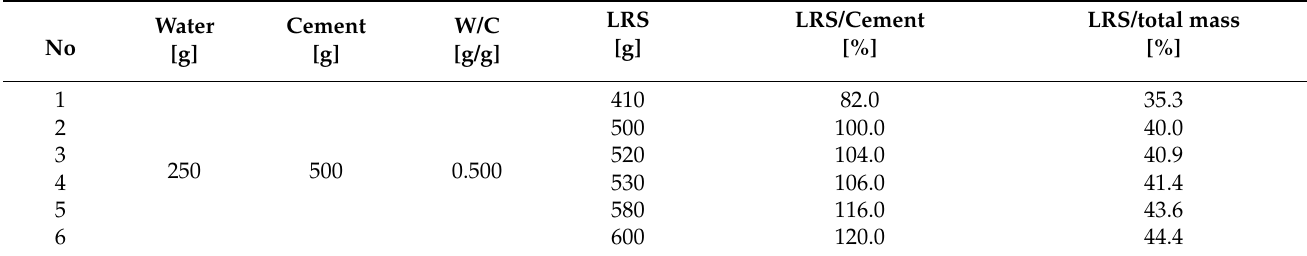
Figure 5. Relation between consistency/plasticity of lunar micro-mortars (expressed by flow diameter) and content of lunar regolith simulant (LRS) acc. to the cement mass ( left ) and the relation between flow diameter and depth of penetration in the Vicat apparatus for the same lunar micro-mortars ( right ); all lunar micro-mortars characterized with constant w/c = 0.265. Table 6. Statistical parameters describing the particle size distribution, specific surface area, and density of regolith simulant (LRS) and quartz powder